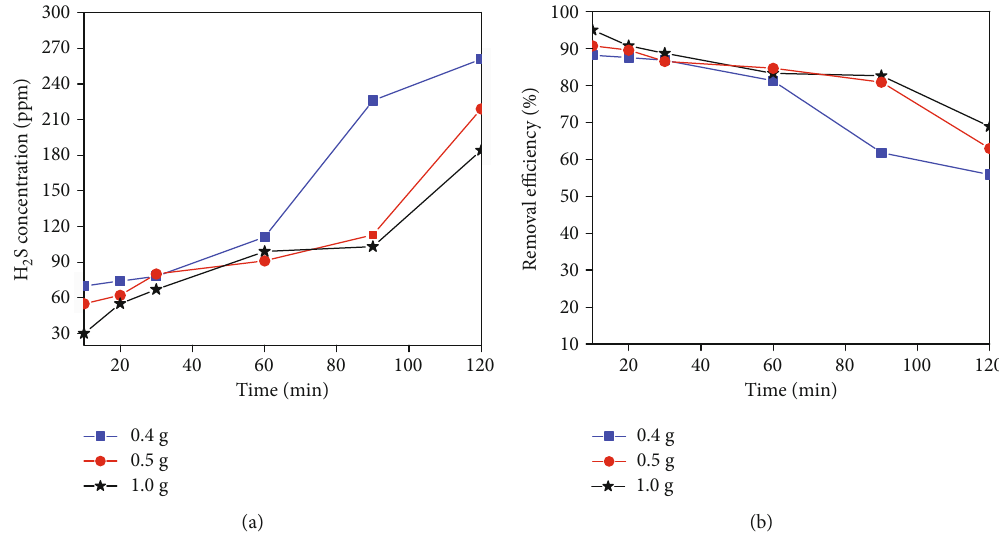
Figure 8: E ff ect of adsorbent mass on the samples ’ adsorption performance: (a) H = 800 ° C , FR = 0 : 02m 3 /h , KOH:C ratio 1: 1, C conditions: T c